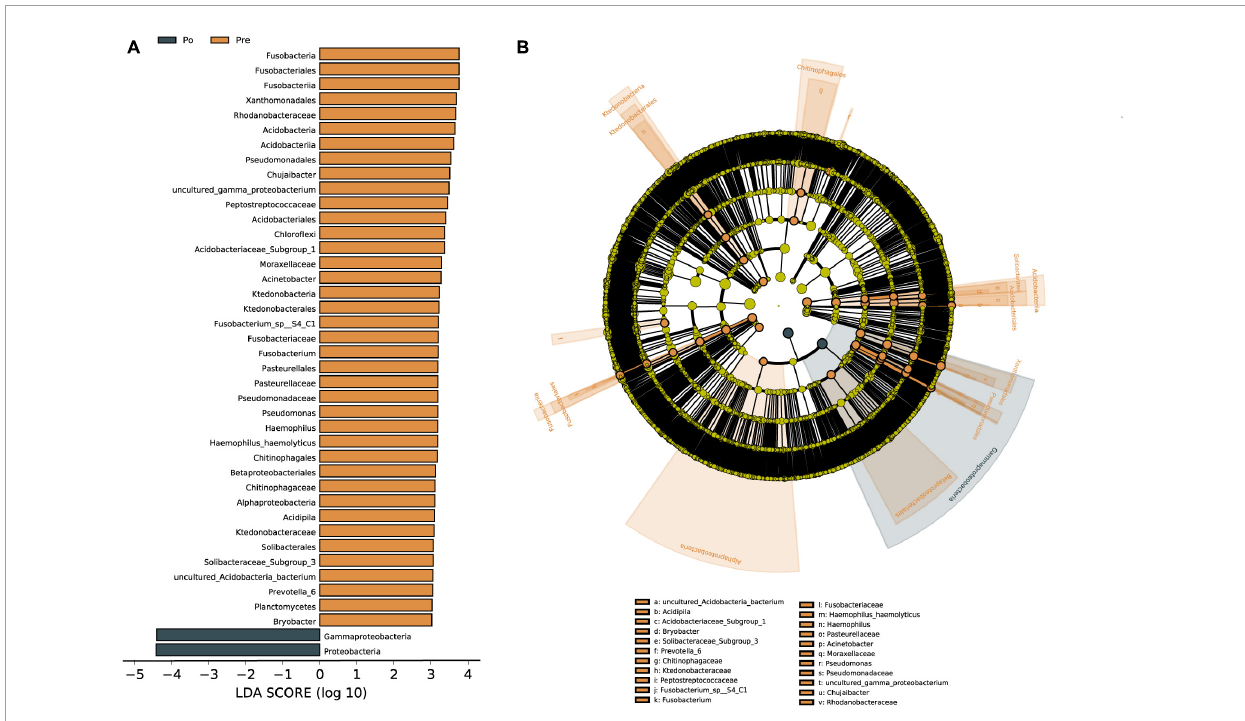
FIGURE4 Vaginal microbiota associated with HIFU operation. Linear discriminant analysis (LDA) effect size (LEfSe) analysis of vaginal microbiota changes following HIFU treatment. Linear discriminant analysis of the differentially abundant genera, which indicated their contribution to group differentiation. Cladogram using LEfSe method indicating the phylogenetic distribution of vaginal microbiota associated with patients with pre-operative group (brown) and post-operative (dark green) (A) . The phylogenetic tree shows LDA scores calculated for differences in genus-level abundance between the pre-operative group and post-operative group (B) . The brown bars indicate that the genus was more abundant in the pre-operative group. The dark green bars indicate that those genera were more abundant in the post-operative